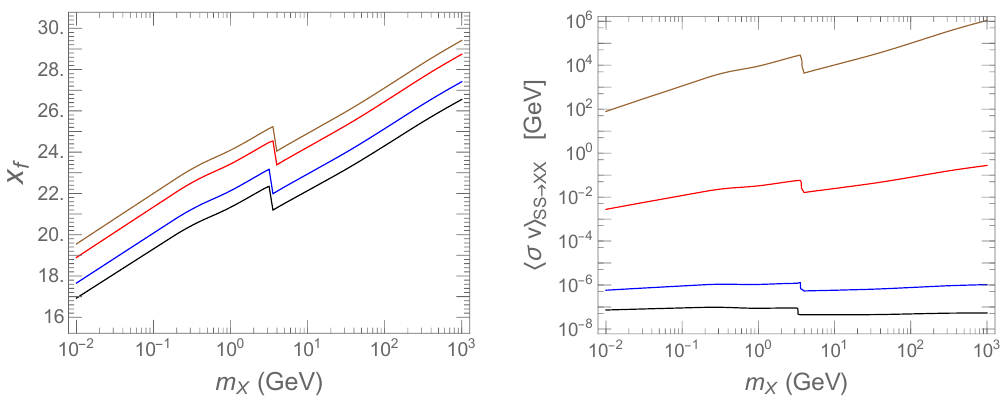
Figure 1 . Left panel: x f as a function of m X . Right panel: h σv i SS → XX that can produce the correct DM relic density as a function of m X . From bottom to up, the lines (with colors black, blue, red, and brown) correspond to r = 1 . 01 , 1 . 05 , 1 . 25 , and 1 . 5 , respectively. The unsmooth part of the curves denotes the QCD phase transition at temperature T QCD = 150